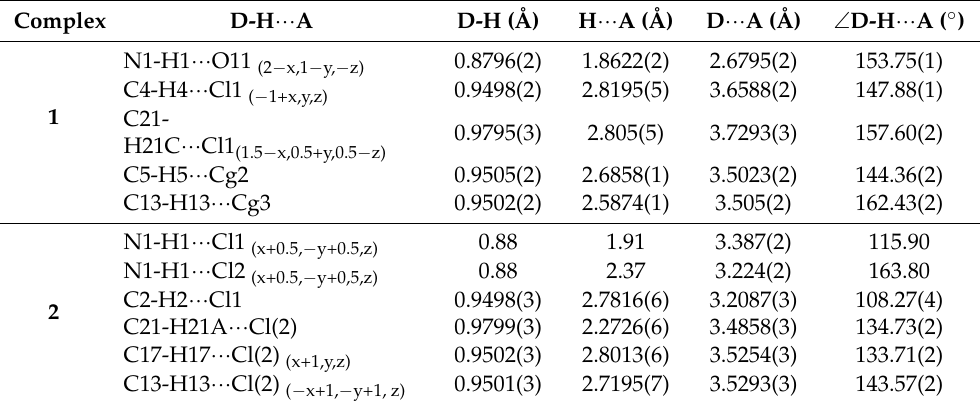
Table 4. Geometry of classical hydrogen bonds and supramolecular interactions of C–H ··· Cl and C–H ··· π types for complexes 1 and 2